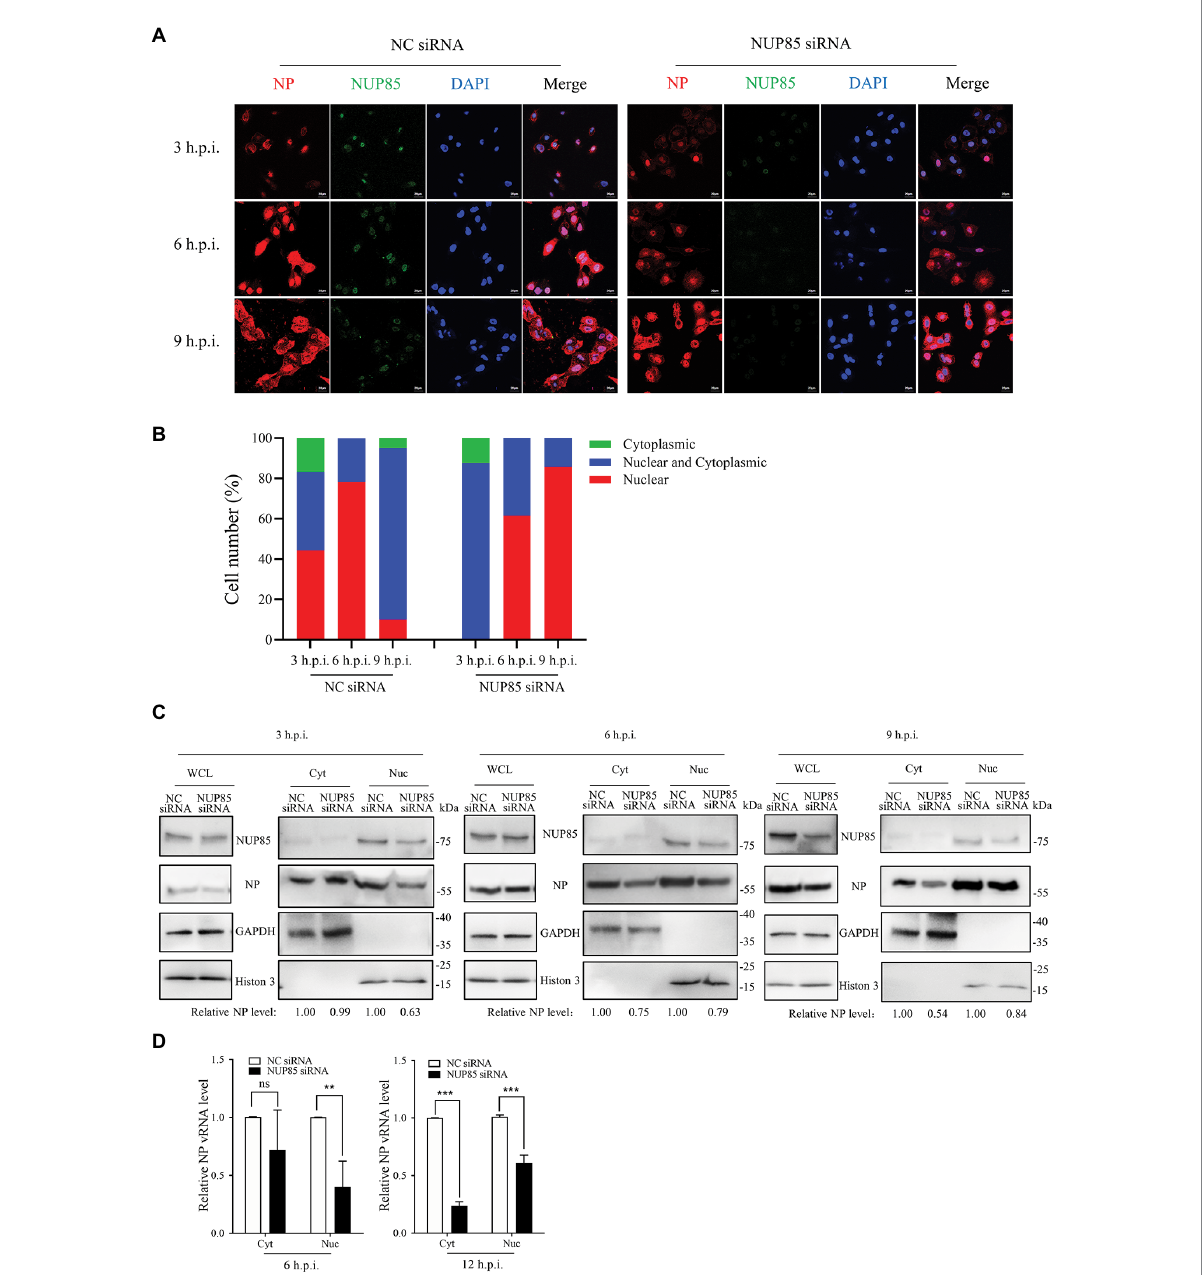
FIGURE 3 Knockdown of NUP85 inhibits the nuclear import of vRNP. (A) Confocal microscopy analysis of the nucleocytoplasmic distribution of vRNP in virus-infected NUP85 knockdown cells. A549 cells were treated with NUP85 siRNA or NC siRNA and then were infected with the H9N2 JSC1 virus (MOI = 3). At 3, 6, and 9 h post-infection, cells were fixed, permeabilized, and stained with mouse anti-NP (red), rabbit anti-NUP85 (green) and DAPI (blue). The scale bar represents 20 μ m. Images are representative of three independent experiments. (B) Quantitative analysis of vRNP localization in the infected cells was performed by calculating cell numbers with related fluorescence. At least 100 cells in each group were scored. (C) Western blot analysis of the distribution of NP in the cytoplasmic and nuclear fractions in virus-infected NC siRNA and NUP85 siRNA-treated cells. A549 cells were treated with NUP85 siRNA or NC siRNA and then were infected with the H9N2 JSC1 virus (MOI = 3). Cells were harvested at 3, 6, and 9 h.p.i. Then, the nucleocytoplasmic distribution of NP was examined by Western blot and grayscale analysis. The relative protein level of NP in nucleus is indicated with its gray intensity divided by that of Histone 3, and the relative protein level of NP in cytoplasmic is indicated with its gray intensity divided by GAPDH. Then they are normalized by that of control group, the results of which are shown at the bottom panel. Images are representative of three independent experiments. (D) qRT-PCR analysis of the distribution of viral vRNA in the cytoplasmic and nuclear fractions in virus-infected NC siRNA and NUP85 siRNA-treated cells. A549 cells were treated with NUP85 siRNA or NC siRNA and then were infected with the H9N2 JSC1 virus (MOI = 3). Cells were harvested and the cytoplasmic and nuclear parts were fractionated at 6, and 12 h.p.i., followed by qRT-PCR to detect the relative level of NP vRNA. Data are mean ± SD of three independent experiments. Significance is measured by unpaired T -test; ns, no significance. ** indicates p < 0.01. *** indicates p <